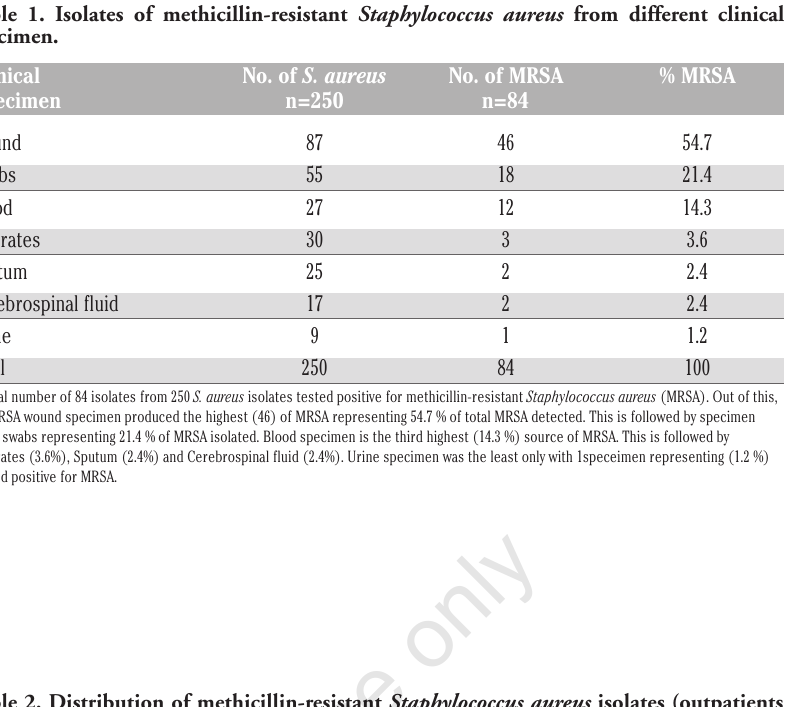
Table 2. Distribution of methicillin-resistant Staphylococcus aureus isolates (outpatients and inpatient). Clinical